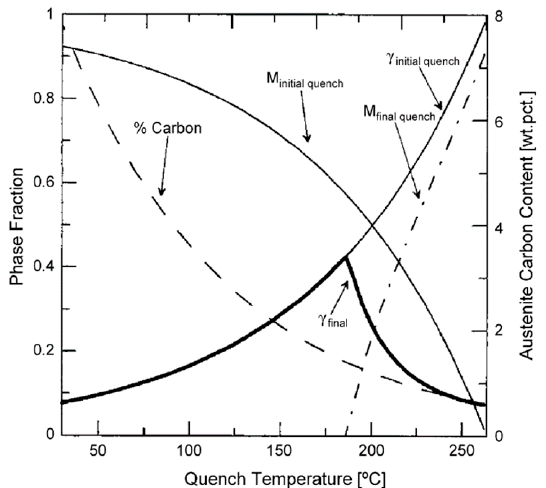
Figure 2. Predicted phase fractions of the microstructure after the QP process [5]. Copyright obtained from Elsevier. The solid bold line corresponds to the final austenite fraction at room temperature. Solid lines illustrate the austenite ( γ ) and martensite (M) fraction at the first quenching temperature, and the dash-dotted line represents the as-quenched or fresh martensite that forms during the final quench. Reproduced with permission of the editor.